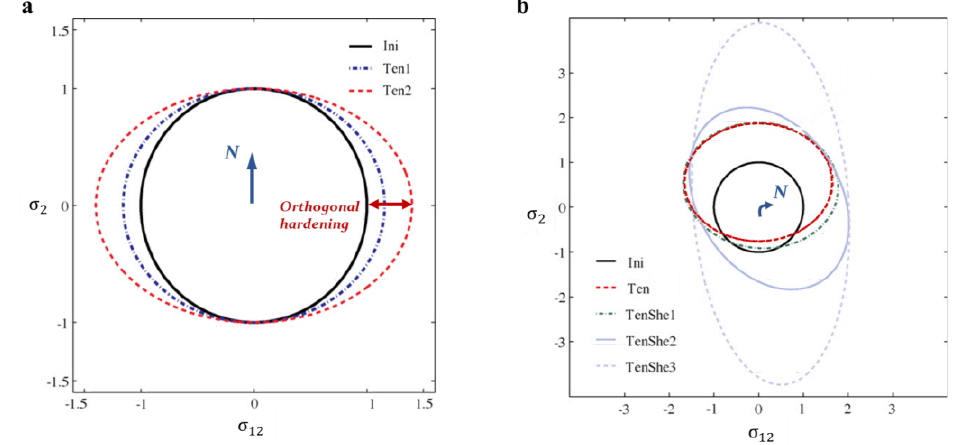
Figure 11. Evolution of the normalized yield surface in the Noman 10 model in the cases of ( a ) pro- portional loading and ( b ) continuous loading path changes. Reprinted with permission from Ref. [65]. 2009, Noman, M. et